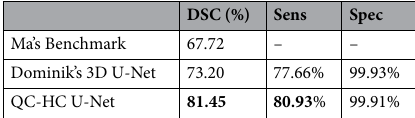
Table 3. Comparison of MSD tumor segmentation.